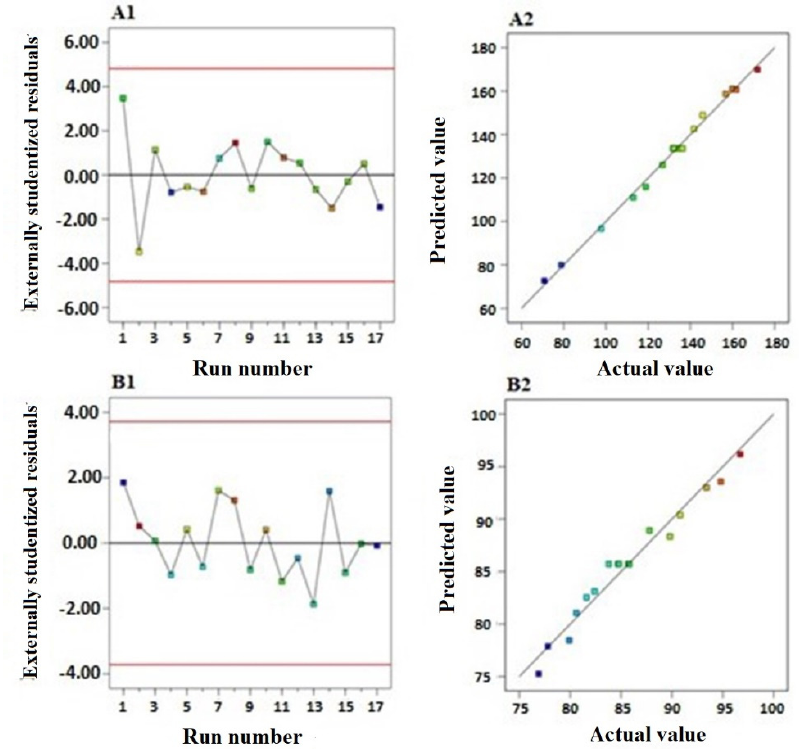
Figure 1. The diagnostic plots for vesicle size: ( A1 ) externally studentized residuals vs. run number plot and ( A2 ) predicted vs. actual values plot. The diagnostic plots for the entrapment efficiency of SMV-EMLs: ( B1 ) externally studentized residuals vs. run number plot and ( B2 ) predicted vs. actual values plot.